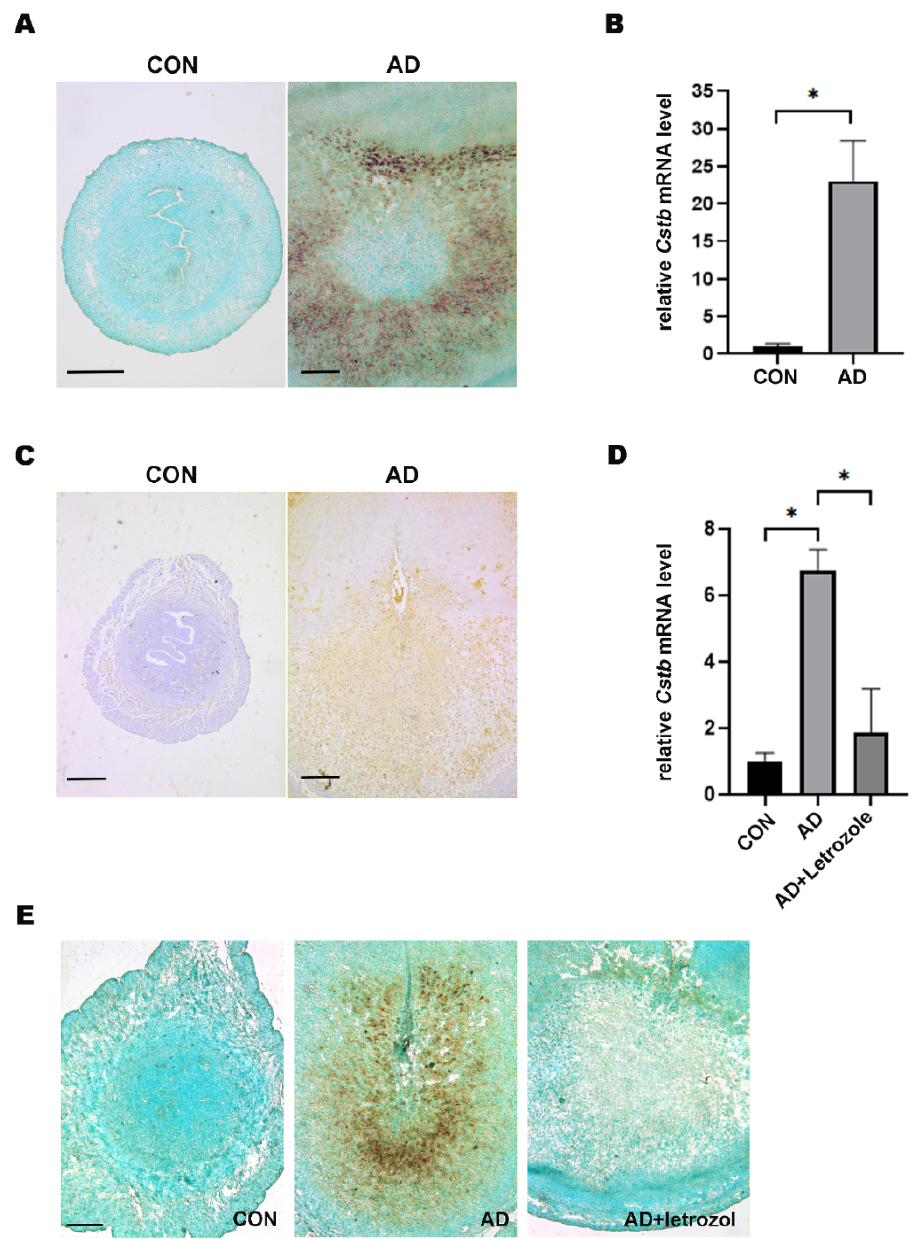
Figure 3. Endogenous estrogen in the womb is involved in the regulation of Cstb expression during decidualization. ( A ) The uteruswas collected on day 8 by injecting oil into the pseudopregnant uterus on the morning of day 4. Cstb mRNA signal was detected by in situ hybridization. Bar = 300 μ m. ( B ) The expression of Cstb was detected by RT-qPCR. ( C ) The expression of Cstb was detected by immunohistochemistry. Bar = 300 μ m. ( D ) The expression of Cstb was detected by RT-qPCR. ( E ) The expression of Cstb was detected in situ hybridization. CON, control; AD, Artificial decidualization; Letrozole: aromatase inhibitor. Bar = 300 μ m. * p < 0.05.